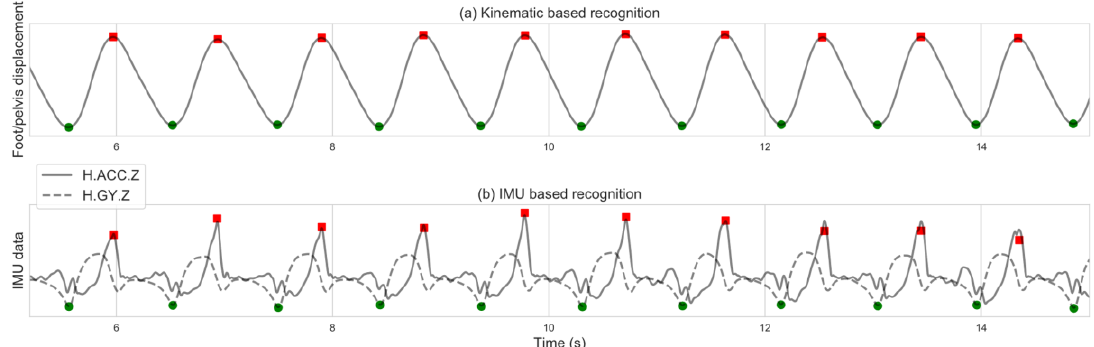
Figure 2. Forward walking gait events identification based on: ( a ) kinematic data; ( b ) IMU data. Red squares indicate initial foot contact (heel strike); green circles indicate terminal foot contact (toes off).